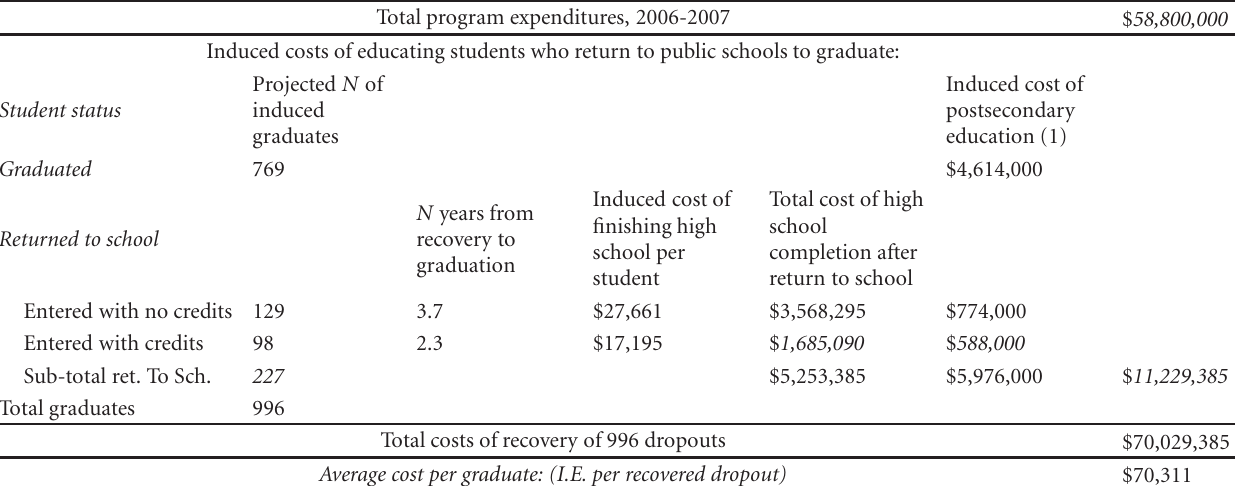
Table 4: Costs of OFY/OFL Dropout recovery, 2006-2007; Total and average costs Per HS graduate.